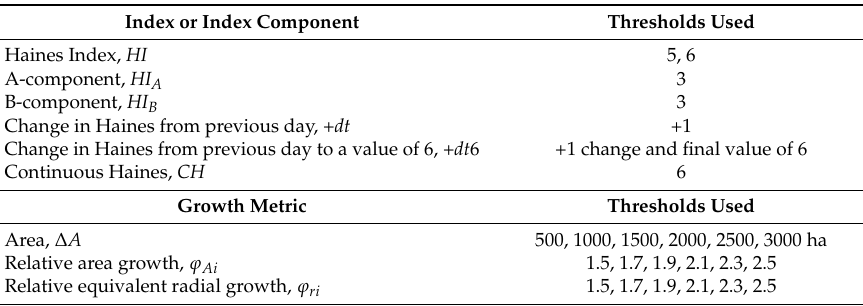
Table 3. Index and growth thresholds used to compute contingency